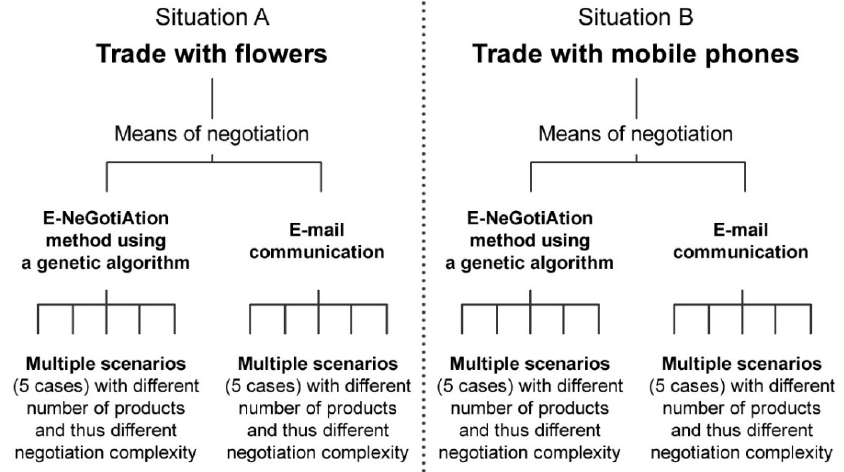
Figure 1. Structure of the case study.